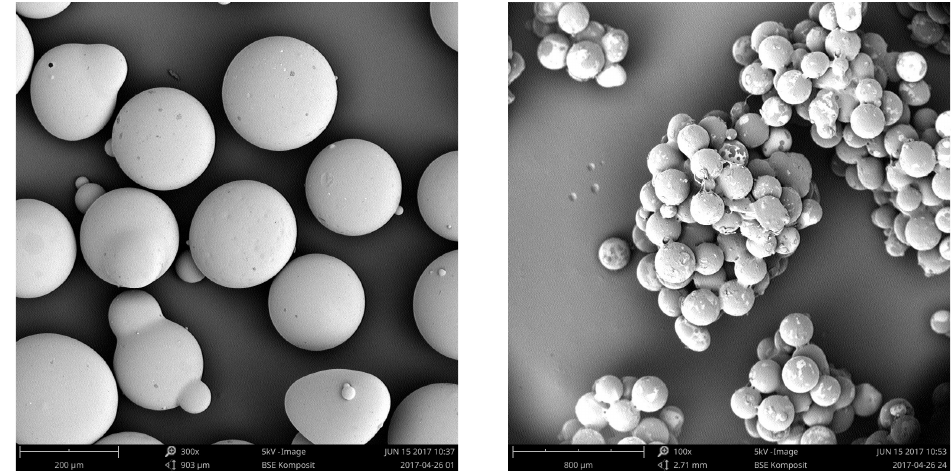
Figure 2. ( Left ) Scanning electron microscope (SEM) picture of primary particles; ( Right ) SEM picture of agglomerates at steady